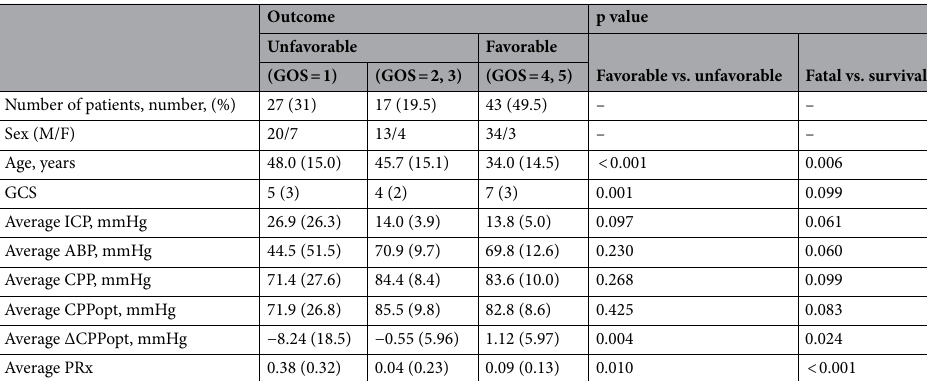
Table 1. Demographic and multimodal monitoring data of TBI patients. Here, ICP is the intracranial pressure, ABP is the arterial blood pressure, CPP is the cerebral perfusion pressure, PRx is the pressure reactivity index, ΔCPPopt is declination of CPP from CPPopt, GCS is the Glasgow Coma Scale, GOS is the Glasgow Outcome Score after 6 months. Favorable outcomes are good recovery (GOS = 5) and moderate disability (GOS = 4), and unfavorable outcomes are severe disability (GOS = 3), vegetative state (GOS = 2), or death (GOS = 1). The p values are calculated by using the Mann–Whitney U test for differences between the groups with favorable (GOS = 4,5) and unfavorable (GOS = 1,2,3) outcomes and between the groups with survival (GOS = 2,3,4,5) and fatal (GOS = 1) outcomes (significant if p < 0.05). Age and average ICP, ABP, CPP, PRx, ΔCPPopt values expressed by mean with standard deviation (in brackets). The GCS is expressed as the median and interquartile range in brackets.